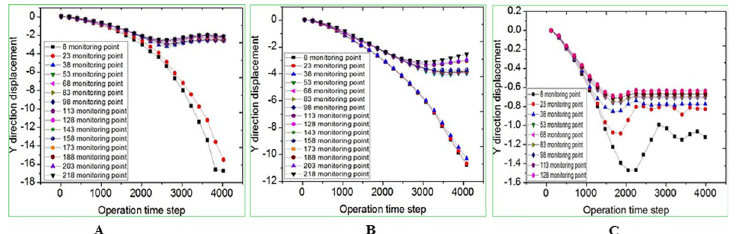
Fig 16. Displacement curve of monitoring point on the same X-axis in the Y-axis direction. (A) Inverted funnel. (B) Columnar. (C)